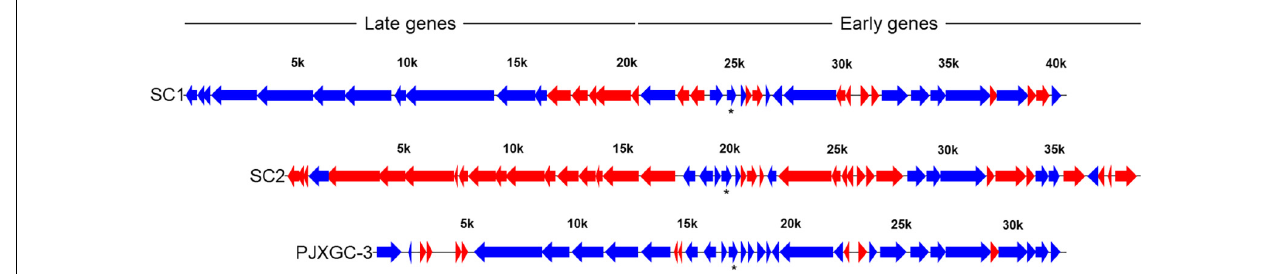
FIGURE 5 | Read mapping against “ Candidatus Liberibacter asiaticus” (Las) SC1 (type 1) and SC2 (type 2) prophages from Las UF506 (HQ377374) and P-JXGC-3 (type 3) prophage from Las JXGC (KY661963). Blue arrows indicate genes mapped in at least two libraries while red arrows had no reads mapped. Asterisk is the Las genes with the highest number of mapped reads. Expression level taken from Diaphorina citri gut library from the acquisition time 5/6 days of rearing in Las-infected citrus (Las III).